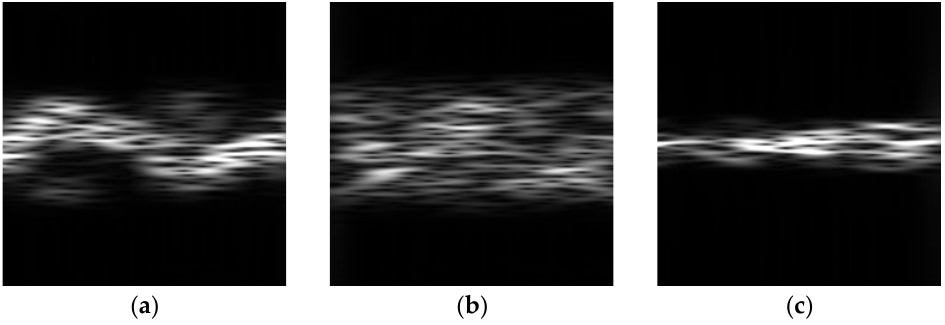
Figure 7. The time–frequency spectrograms of the semi-measured database. ( a ) Walking; ( b ) running; ( c ) jumping.